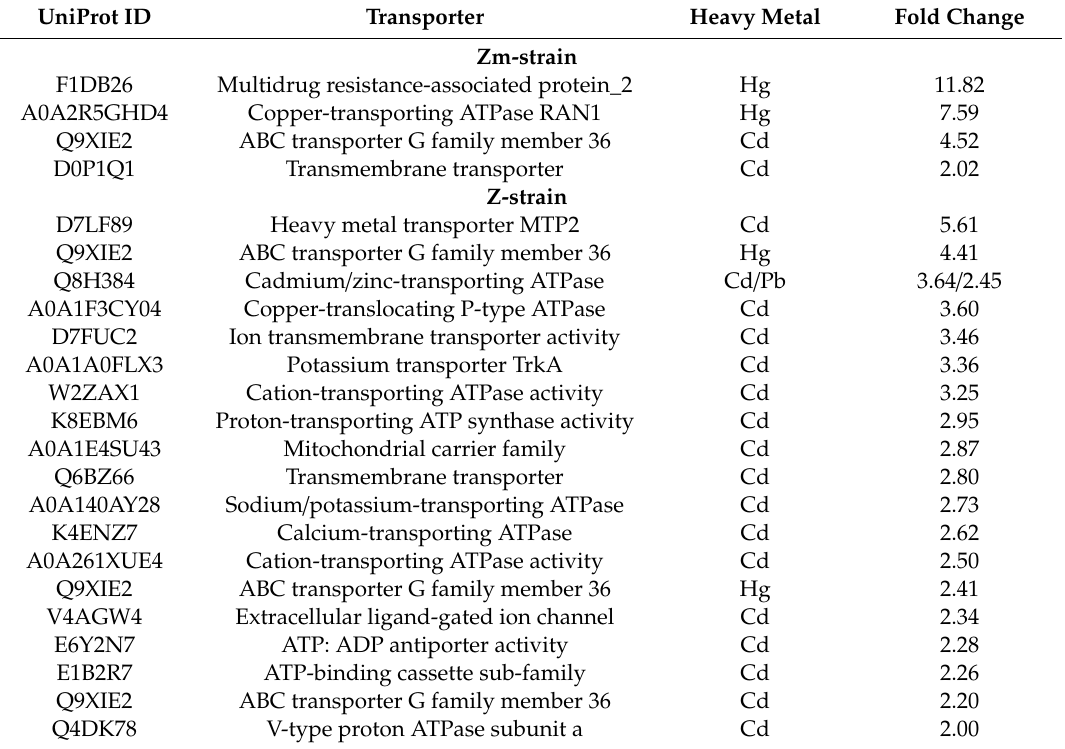
Table 2. The highly abundant transporters (FC > 2) during the Cd, Hg, and Pb treatments in E. gracilis Z- and